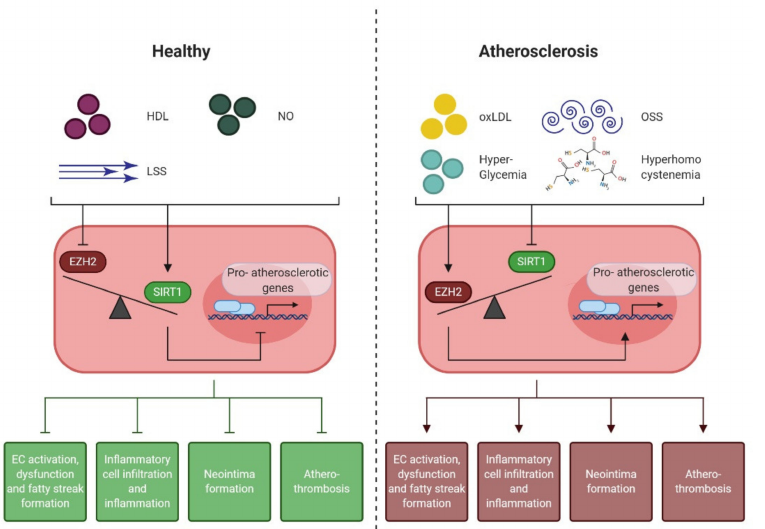
Figure 3. Endothelial cell-derived atheroprotective effects mediated by EZH2 and SIRT1. During homeostasis, high SIRT1, and low EZH2 activity ensure endothelial homeostasis, characterized by NO production, anti-inflammatory signalling, and the inhibition of the expression of atheroprone genes. When the balance between EZH2 and SIRT1 signalling is disturbed by atheroprone risk factors (e.g., oxLDL, OSS, glycemia or hyperhomocysteinemia), endothelial dysfunction is initiated, which accumulated to lipid streak formation, inflammatory cell infiltration and neointima